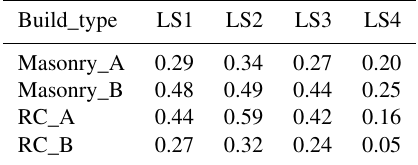
Table B3. The standard deviation in the intensity–PGA relation for each damage limit state of each building